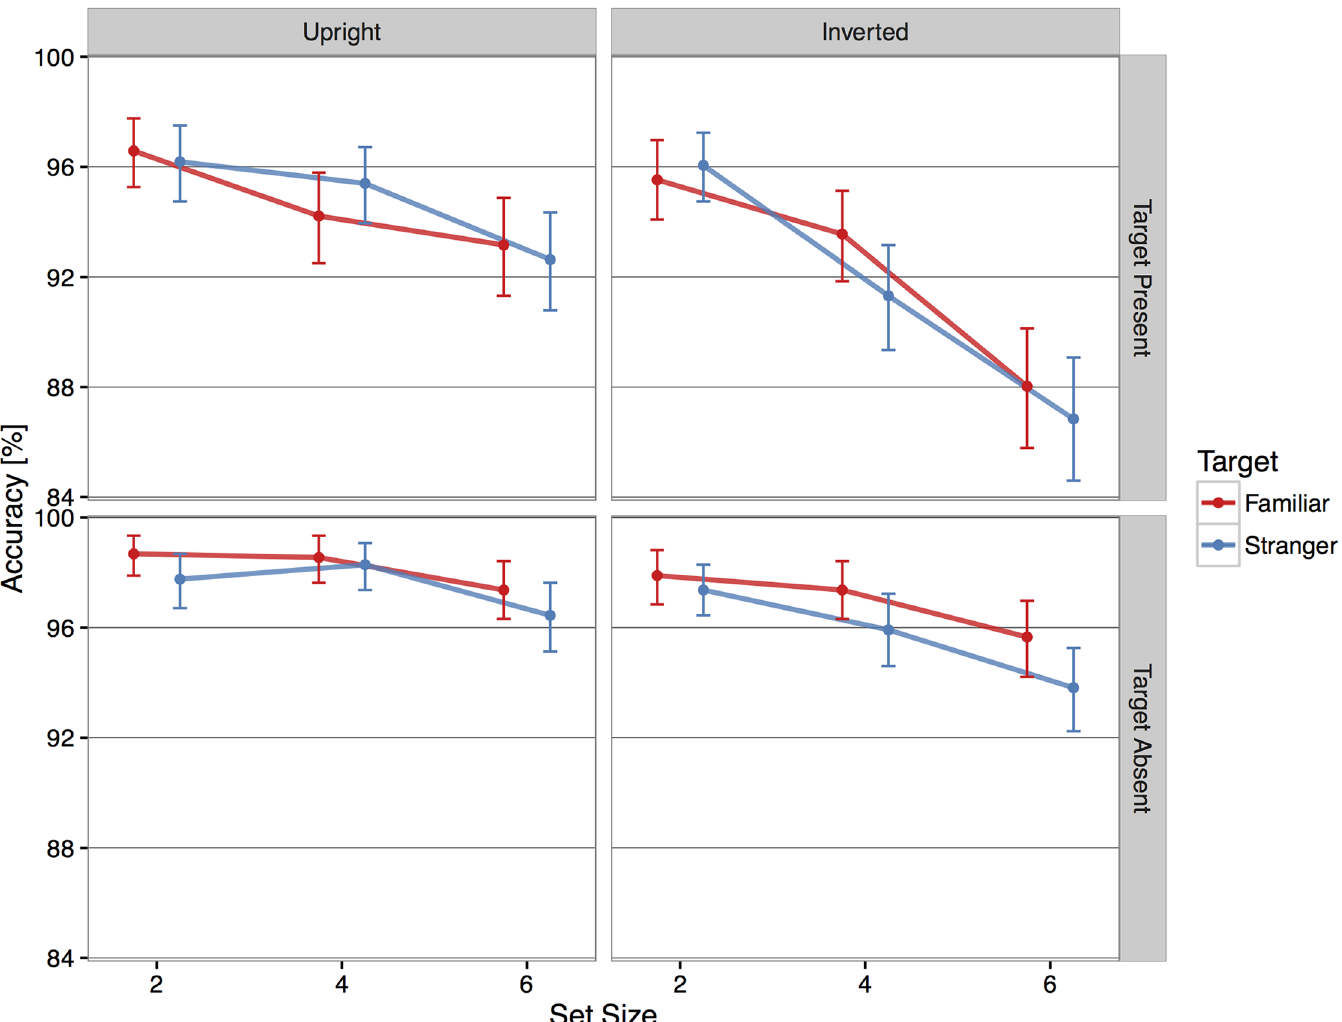
Fig 2. Average accuracyaccording to target orientation (columns) and presenceof the target (rows). Subjects were overall highlyaccurate, with better performance when faces were presentedupright and with fewer distractors. Red: familiar targets; Blue: stranger targets. Error bars show 95% bootstrapped